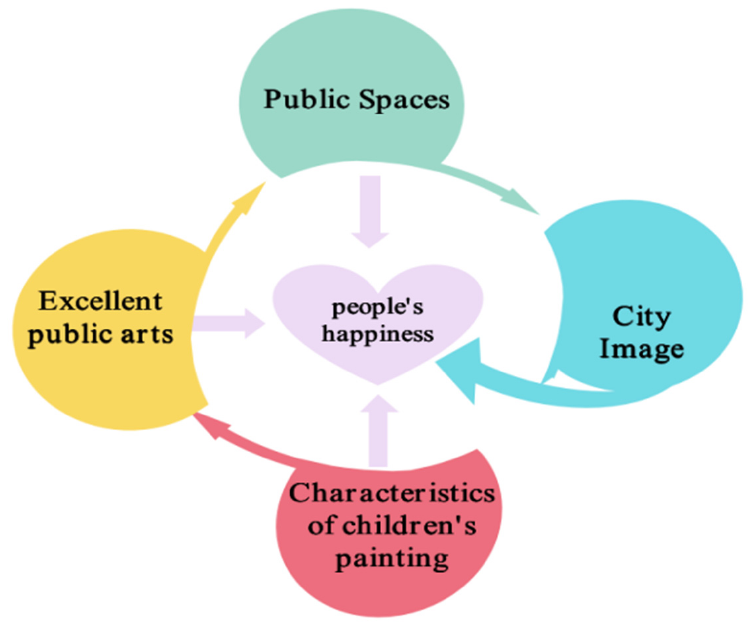
Figure 8. Proposed conceptual framework for public artworks in public spaces for improving people’s happiness.